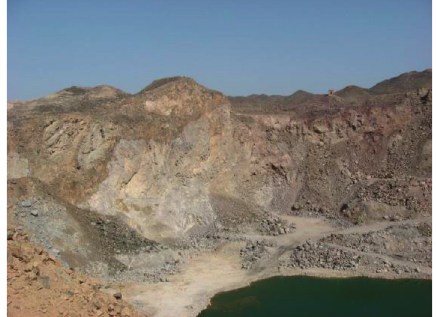
Figure 1: Open-pit mining area.